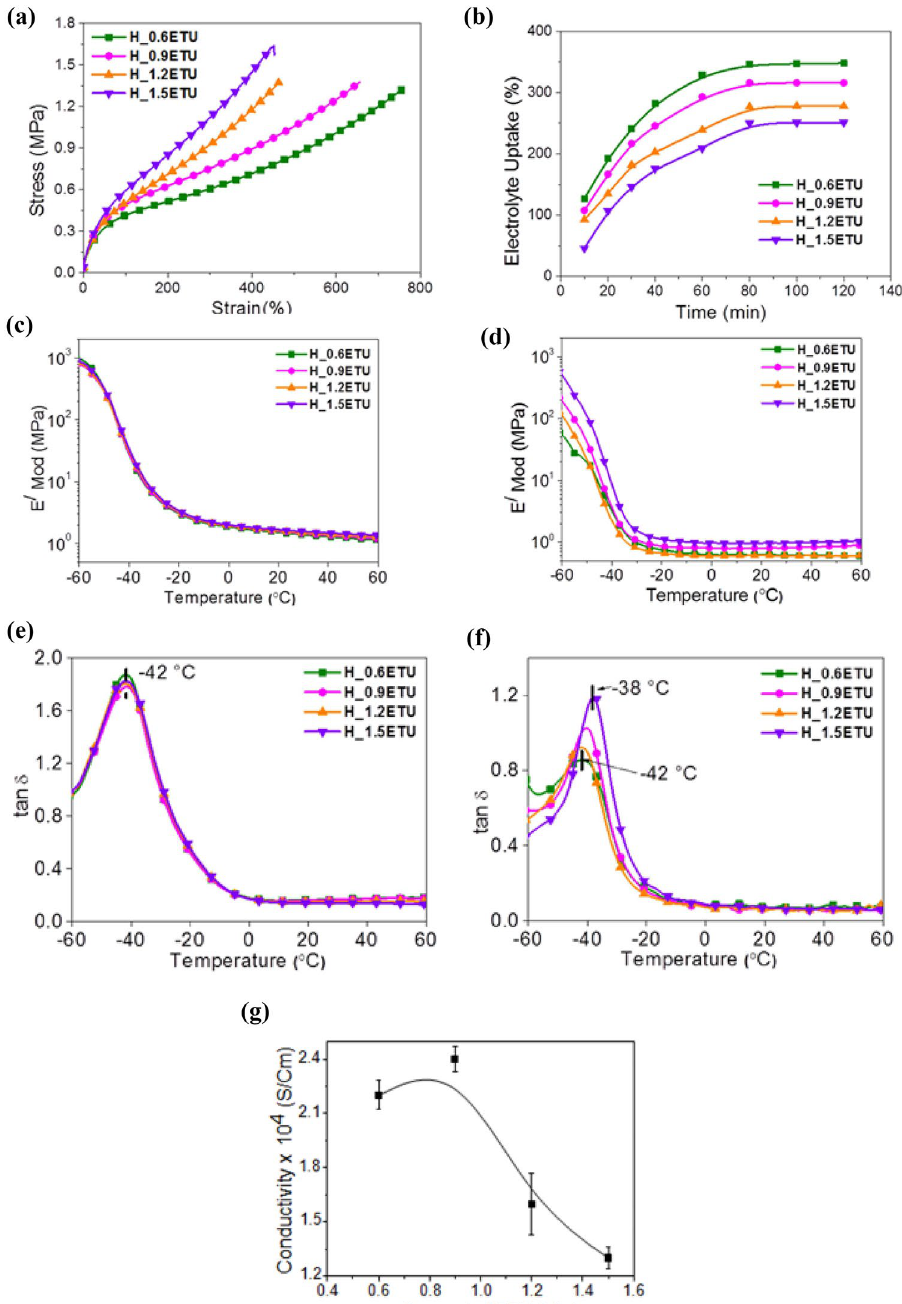
Fig. 5 Illustration a Stress– Strain graphs for cross-linked PEs with a variation of ETU content, b electrolyte loading with respect to time at differ- ent ETU levels. The storage modulus of polymer matrix as a function of temperature at different ETU levels ( c ) before immersion into the electrolyte solution ( d ) after immersion. Tan δ as a function of tempera- ture for the system at different ETU levels, e before dipping and ( f ) after dipping. g Varia- tion of conductivity (S/cm) as a function of the amount of ETU (phr)